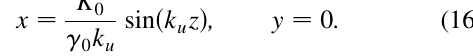
FIG. 4. Electron motion in the longitudinal phase space (cid:2) (cid:8); (cid:9) (cid:3) due to the presence of a resonant EM wave (with an initial phase (cid:1) (cid:1)= 2 ) in the undulator. An initial distribution of the elec- 0 tron beam, shown as a straight line at (cid:9) (cid:1) 0 , changes into a distribution on a sinusoidal line, implying that the energy and the density of the electron beam is modulated, i.e., microbunched. The dashed lines are the phase space